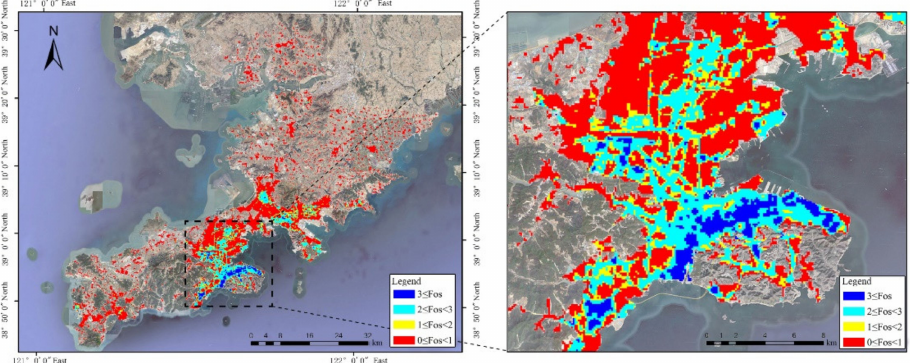
Figure 21. Safety map of night lighting in urban areas of Dalian